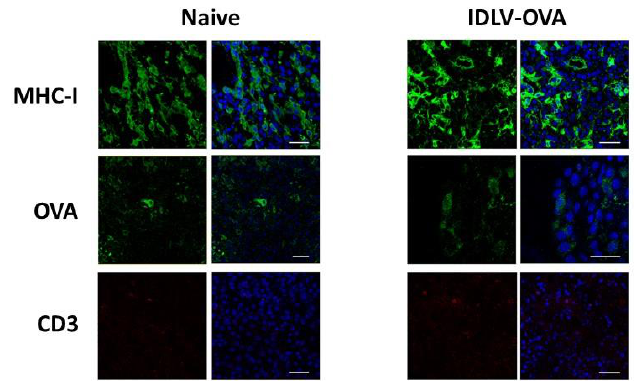
Figure 3. Confocal laser scanning microscopy (CLSM) analyses on mice tissue sections. Representa- tive images of tumor from Naïve and IDLV-OVA mice are shown. Tissue sections 8 µm thick were stained for MHC Class I (green), OVA (green), or CD3 (red) as indicated (left columns) and for DAPI as nuclear staining (blue, right columns). Images represent a 3D reconstruction of 30–40 single Z-stack. Results from one representative experiment are shown for each analysis. Scale bars are 40 µ m.